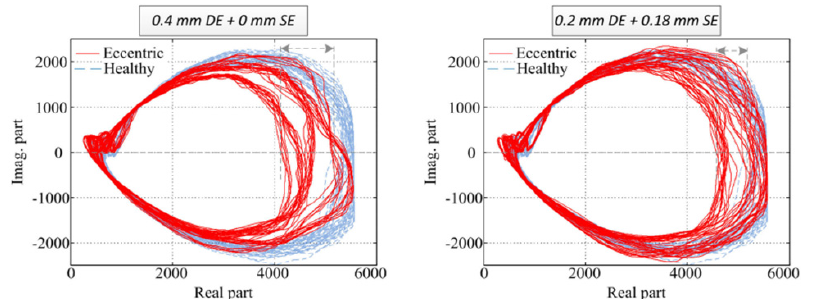
Figure 4. Online diagnostics for a 40-kW PMSM based on inverse transient complex inductance vector theory [15]. vector theory